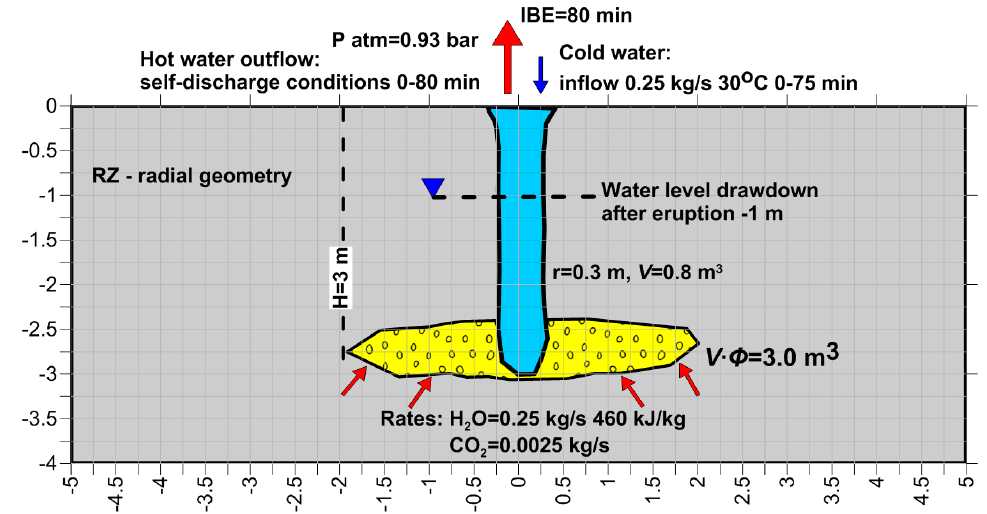
Figure 6. Shaman geyser conceptual model of heat and mass recharge/discharge conditions, conduit (blue) and recharge reservoir (yellow) geometry.